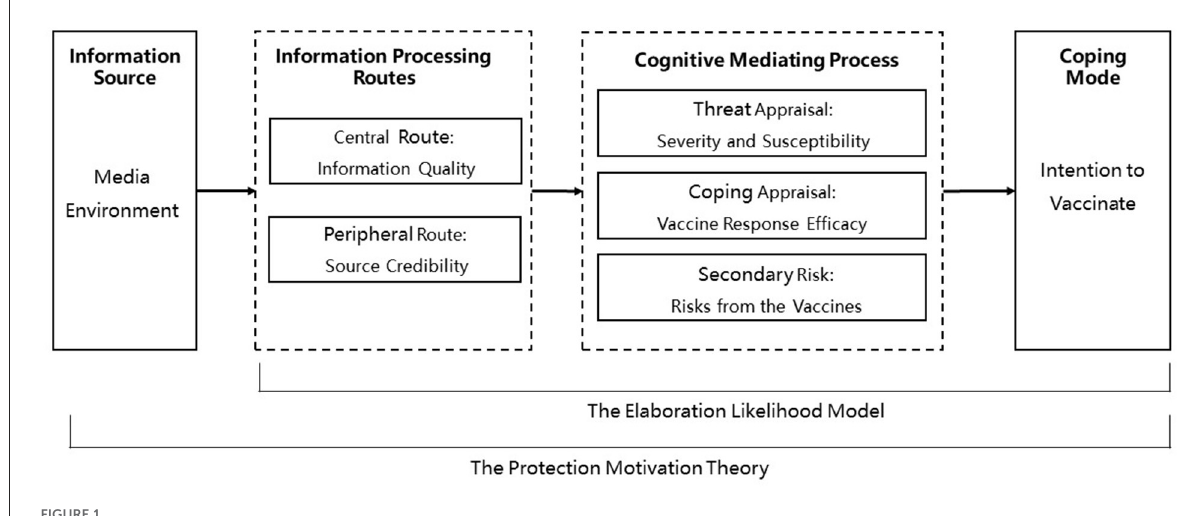
FIGURE1 Research framework.